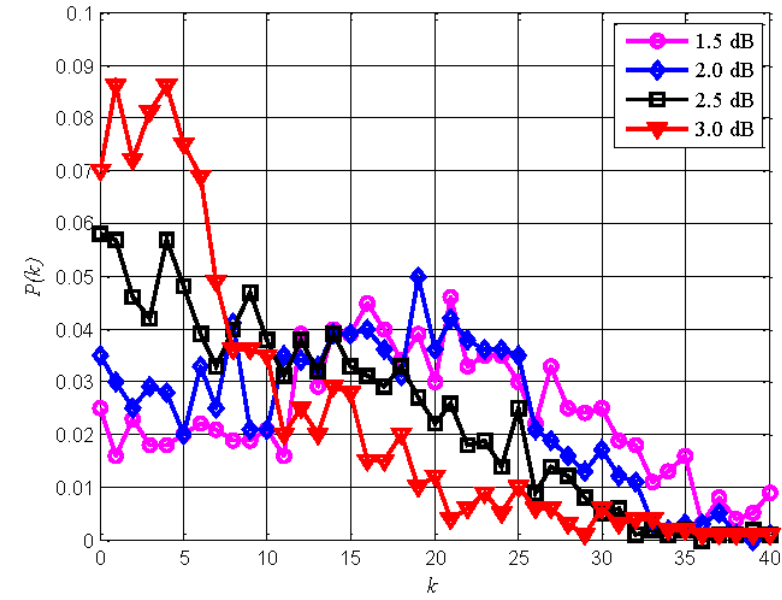
Figure 2. The residual error distribution of LDPC codewords [23].